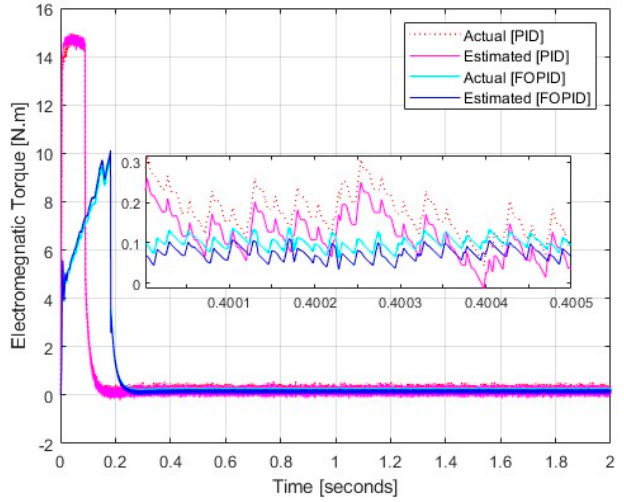
Figure 6. Electromagnetic torque.